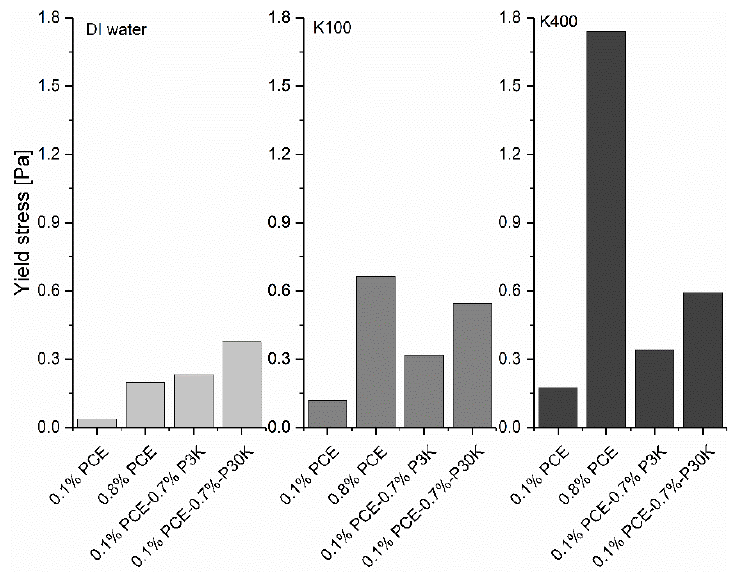
Figure 8. Yield stress of GBS with the addition of PCE and PCE / PEG mixtures with di ff erent [K + ].